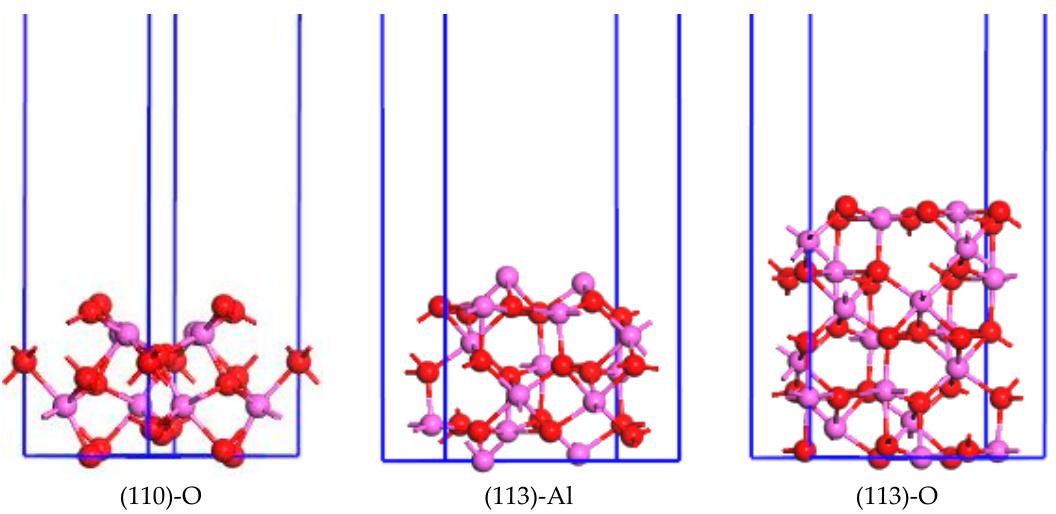
Figure 2. The ball and stick model for the surface structures of Al 2 O 3 . “-Al”and “-O” mean the surfaces terminated by Al atoms and O atoms, respectively. Al atoms, O atoms.